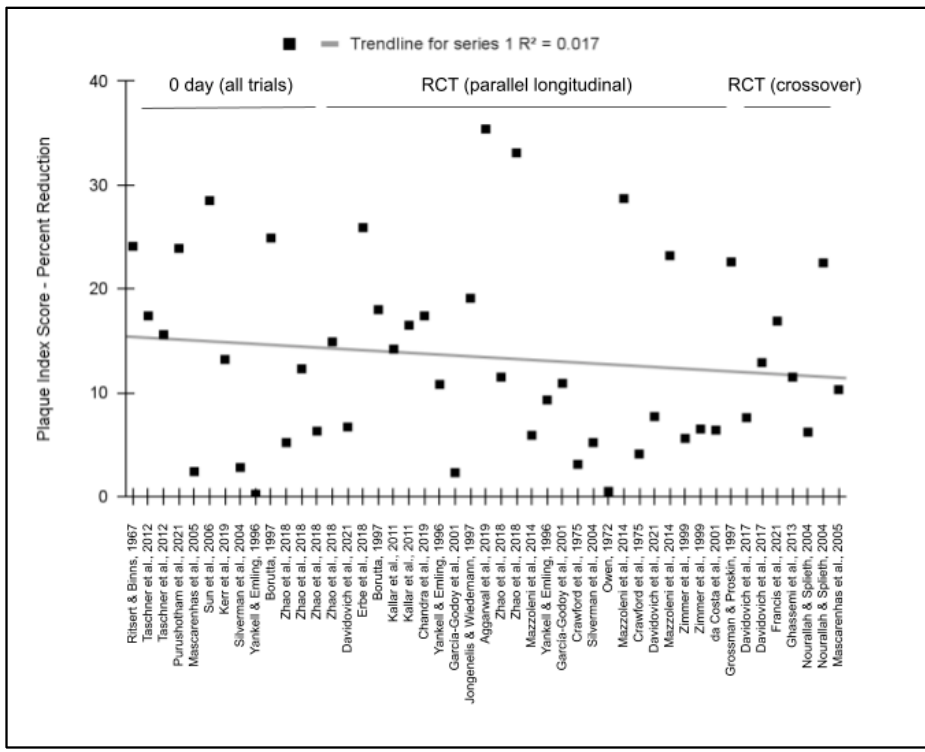
Figure 6. Meta analysis of relative effect (percent reduction in plaque index) plotted against study design. No significant association was found between these variables with a coefficient of determination, R 2 = − 0.017. Studies lasting 0 days exhibited similar average plaque reduction effects (14.2%) as longitudinal RCTs (13.2%), p = 0.767, and crossover RCTs (12.9%), p = 0.735 [22–48]. Full text reviews of all orthodontic pediatric studies (n = 11) were completed (Table